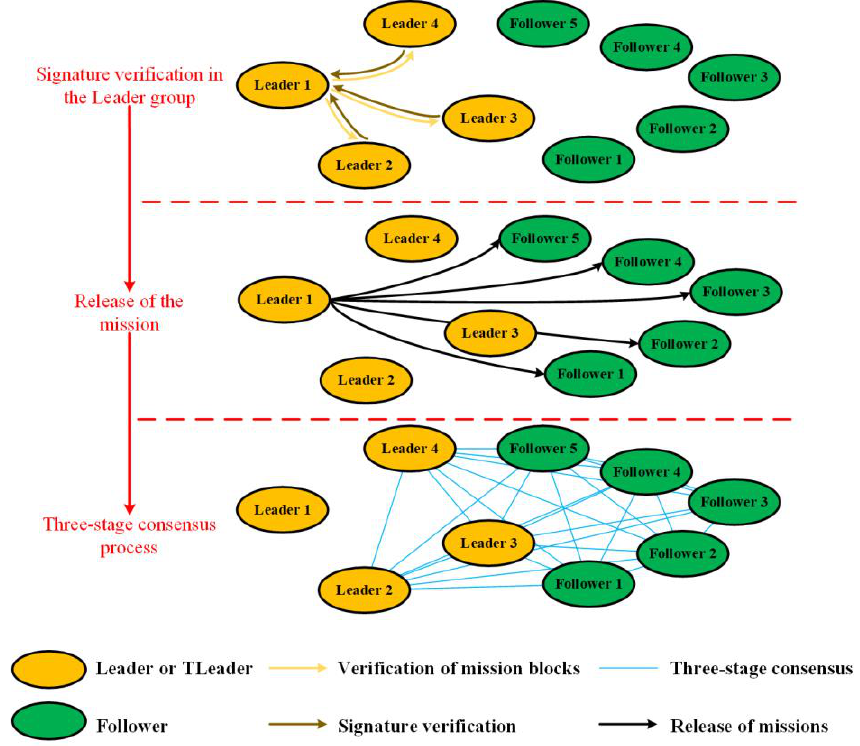
Figure 6. Algorithm flowchart of DPOS.